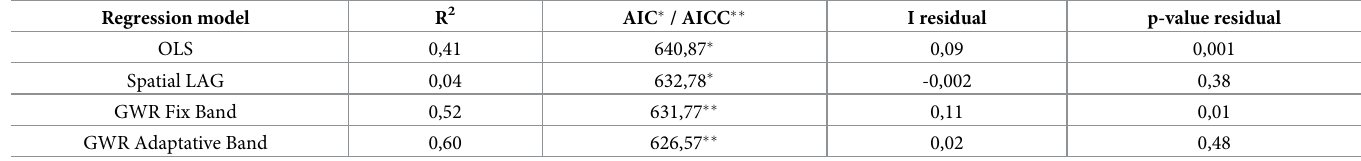
Table 4. Comparison of OLS and GWR models for the impact of SDH on the AIDS mortality rate in Para´ between 2007 and 2018. Regression